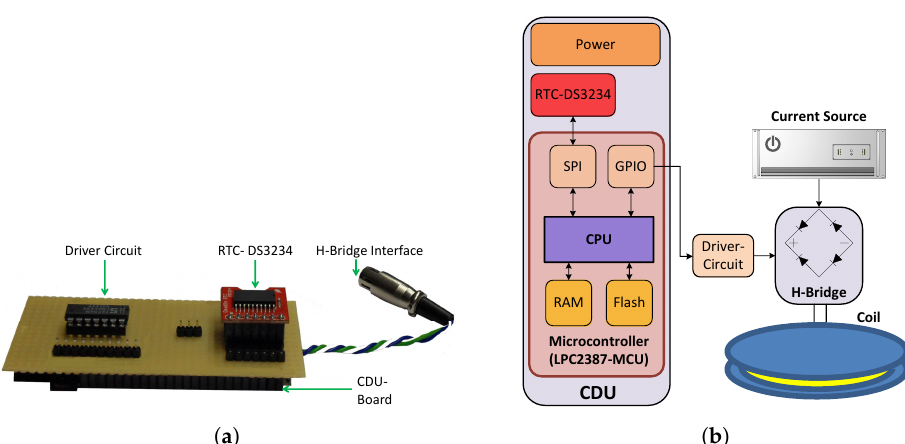
Figure 11. MILPS reference stations hardware. ( a ) Control Driver Unit (CDU), ( b ) simplified hardware block